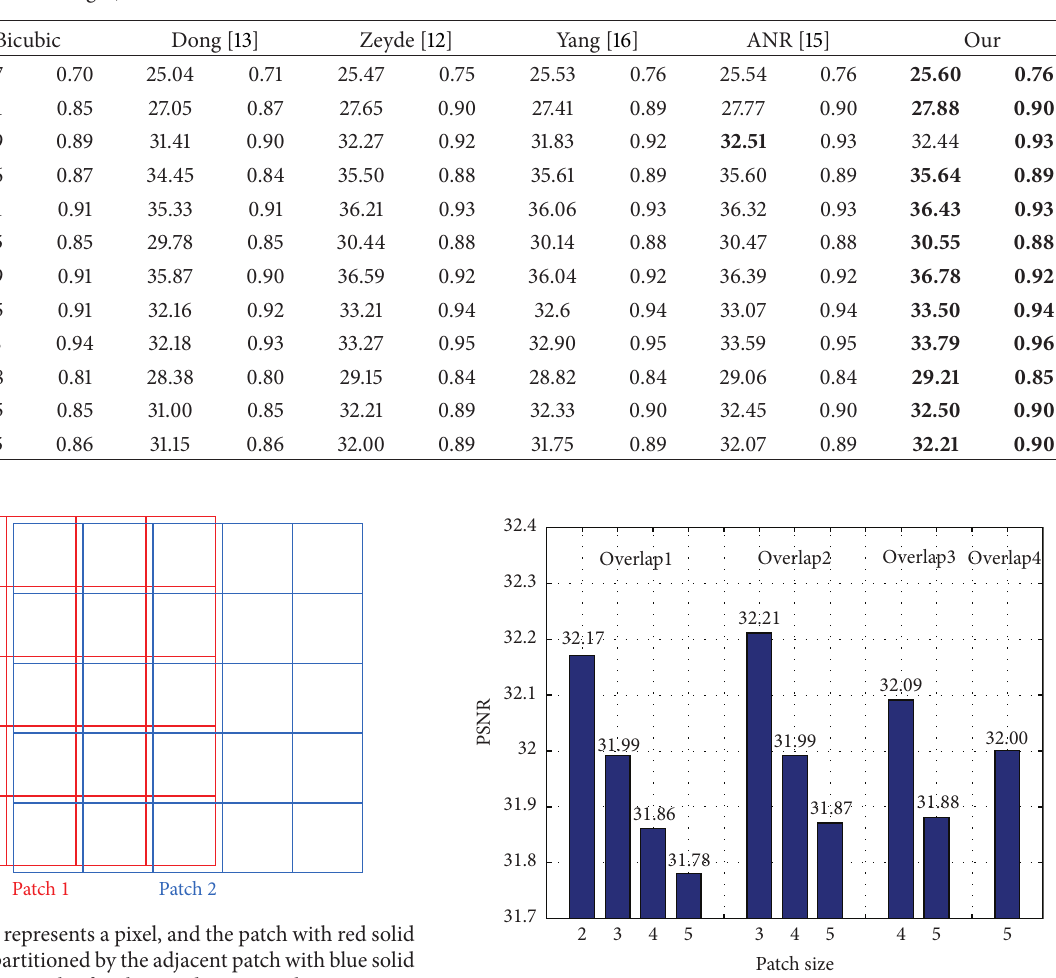
Table 2: The comparisons of the proposed algorithm with other methods by a magnification factor of 2 (for each method, the values are PSNR and SSIM from left to right).